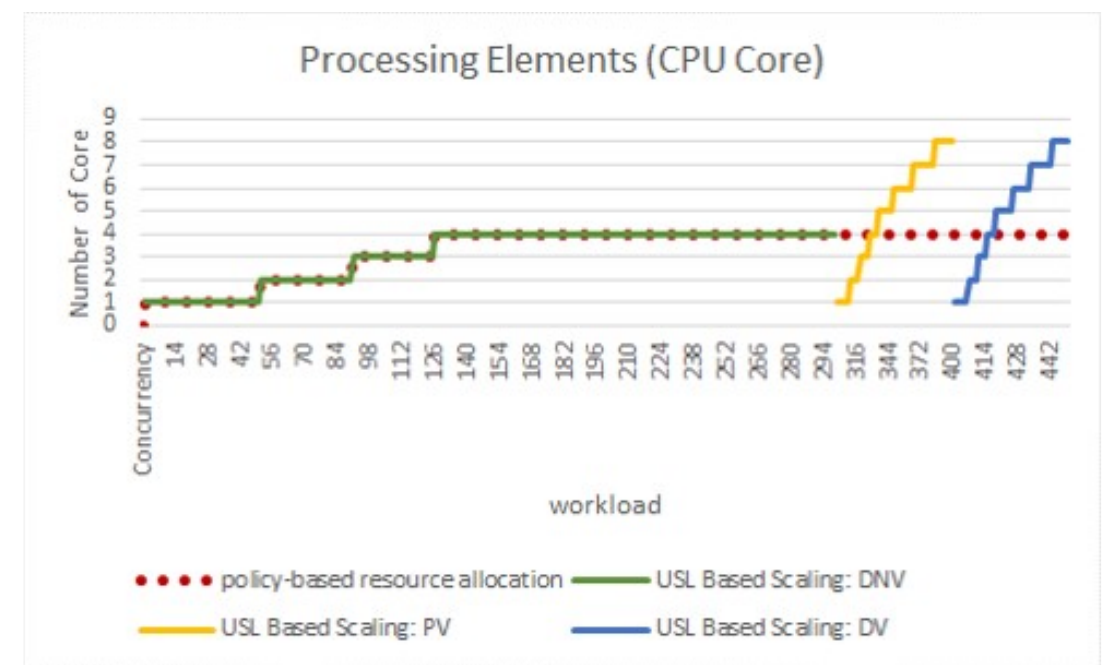
Figure 8. Resource Utilization.